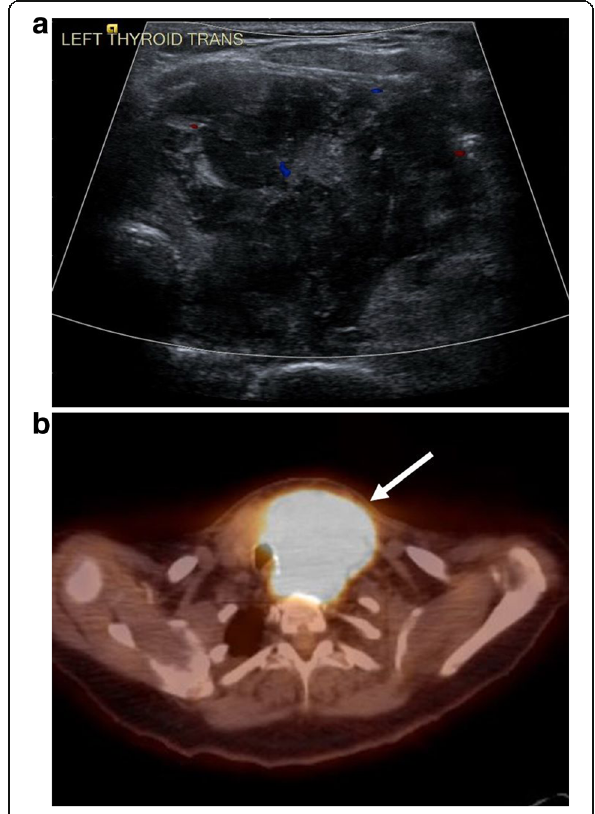
Fig. 11 Thyroid involvement. A 58-year-old female presenting with dysphagia. a Transverse color Doppler image through the left thyroid demonstrates a large, heterogeneous hypovascular mass. b Fused axial PET-CT demonstrates the thyroid mass with rightward tracheal displacement and associated hypermetabolic activity. Biopsy of the thyroid mass revealed Burkitt lymphoma